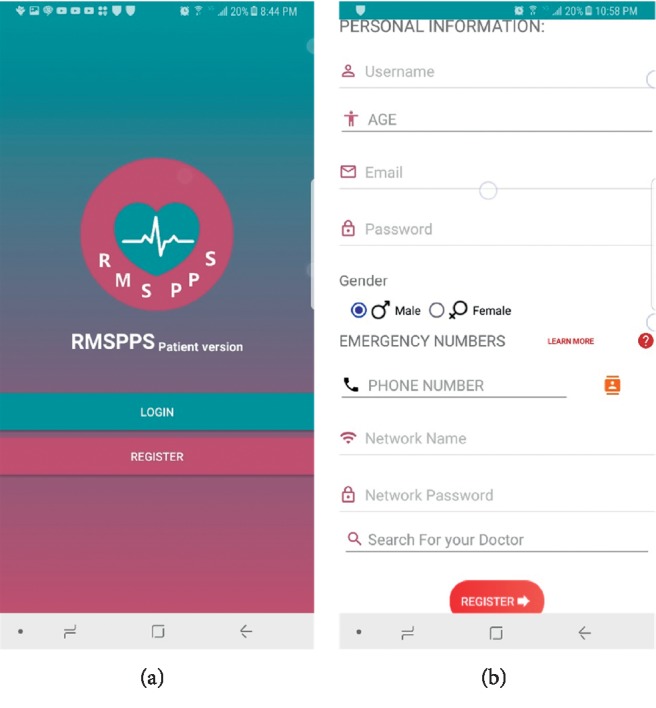
First windows of the patient application: (a) log-in and registration screen option; (b) patient information registration screen (e.g., name, age, gender, and the emergency number of the intended person).